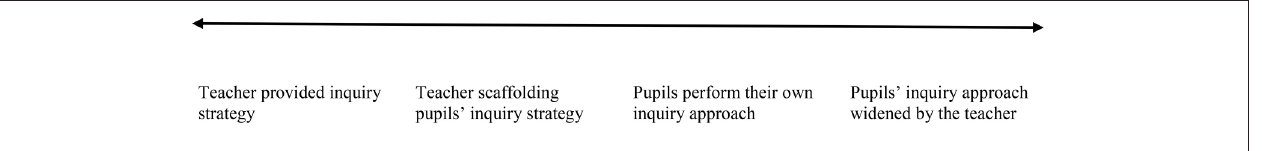
FIGURE 1 | Continuum of teacher guidance in inquiry-based teaching. Inspired by Furtak et al. (2012, p. 306). TABLE 1 | Characteristics of participating teachers and the schools where they